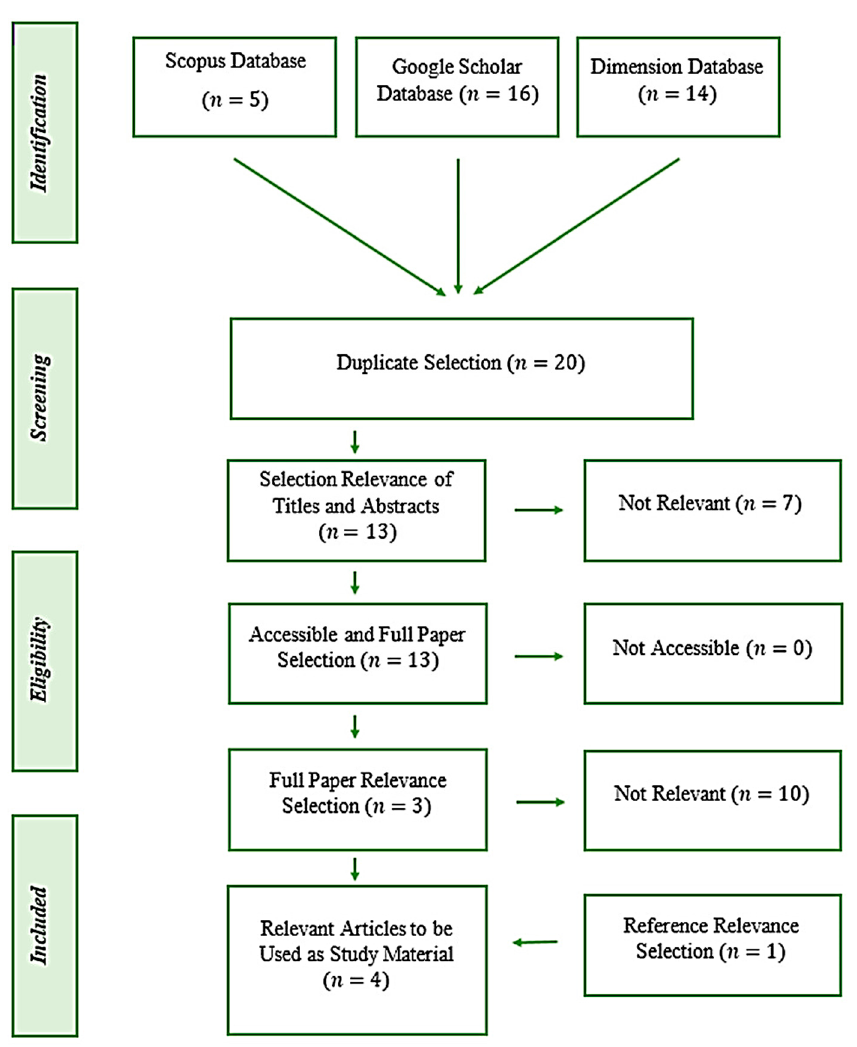
Figure 1. Prisma diagram based on the keywords used.